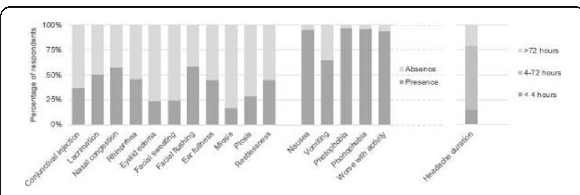
Fig. 2 (abstract P0442). See text for